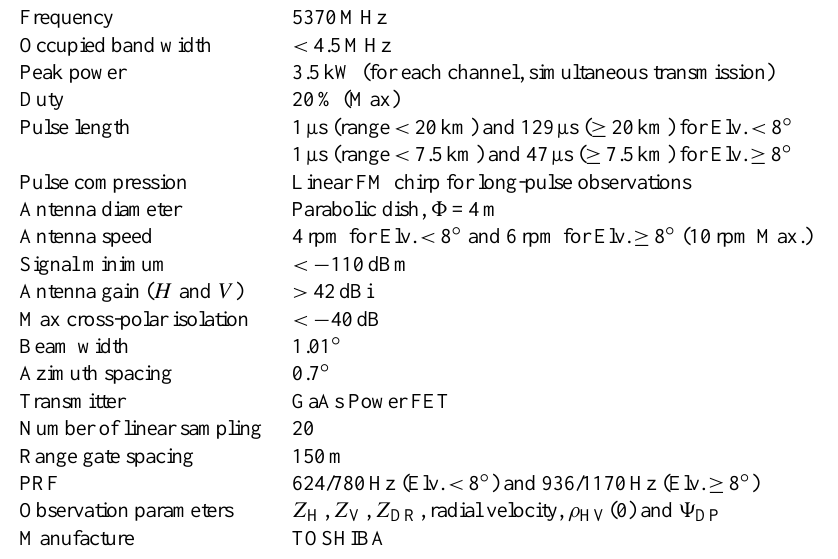
Table 1. Operating characteristics of the MRI C-band polarimetric